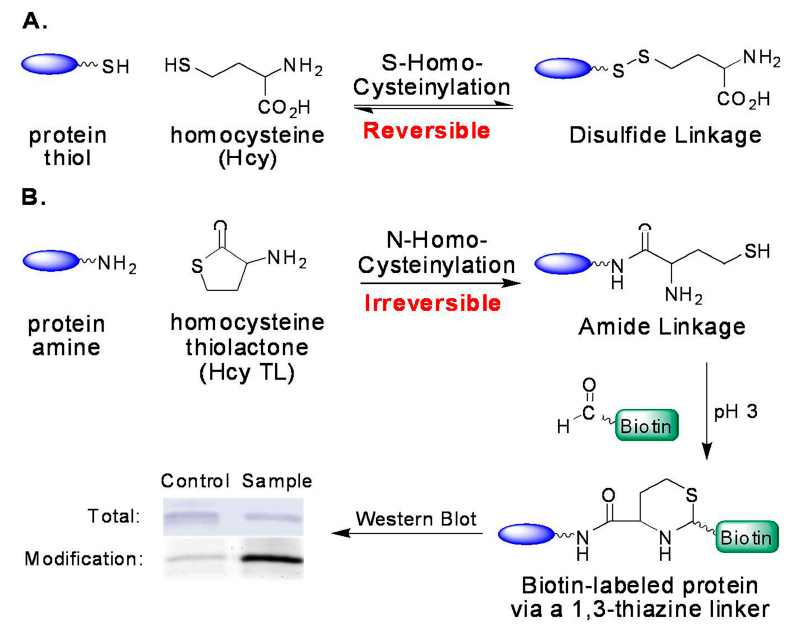
Figure 2. Formation of protein homocysteinylation and detection of N -homocysteinylation via selective tagging with aldehydes. ( A ) Reversible formation of S -homocysteinylation (disulfide); and ( B ) irreversible formation of N -homocysteinylation (amide) and its detection.